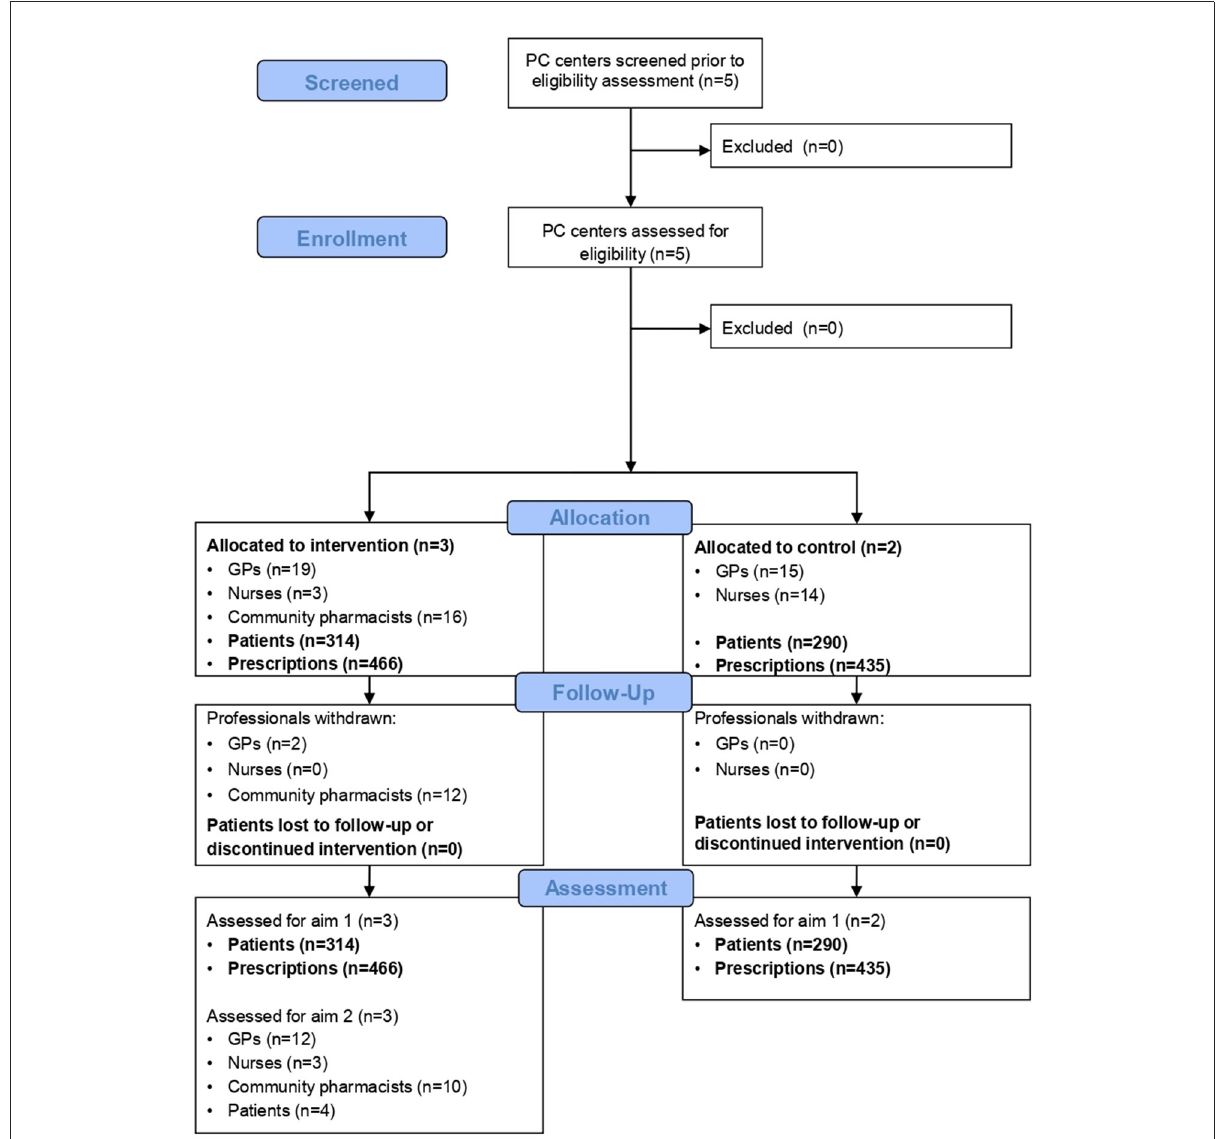
FIGURE2 CONSORT Flow diagram (36). GP, general practitioner; PC, primary care. Aim 1: To test the availability and quality of data used to assess the effectiveness and cost-effectiveness of the IMA intervention. Aim 2: To evaluate the feasibility and acceptability of the IMA intervention in